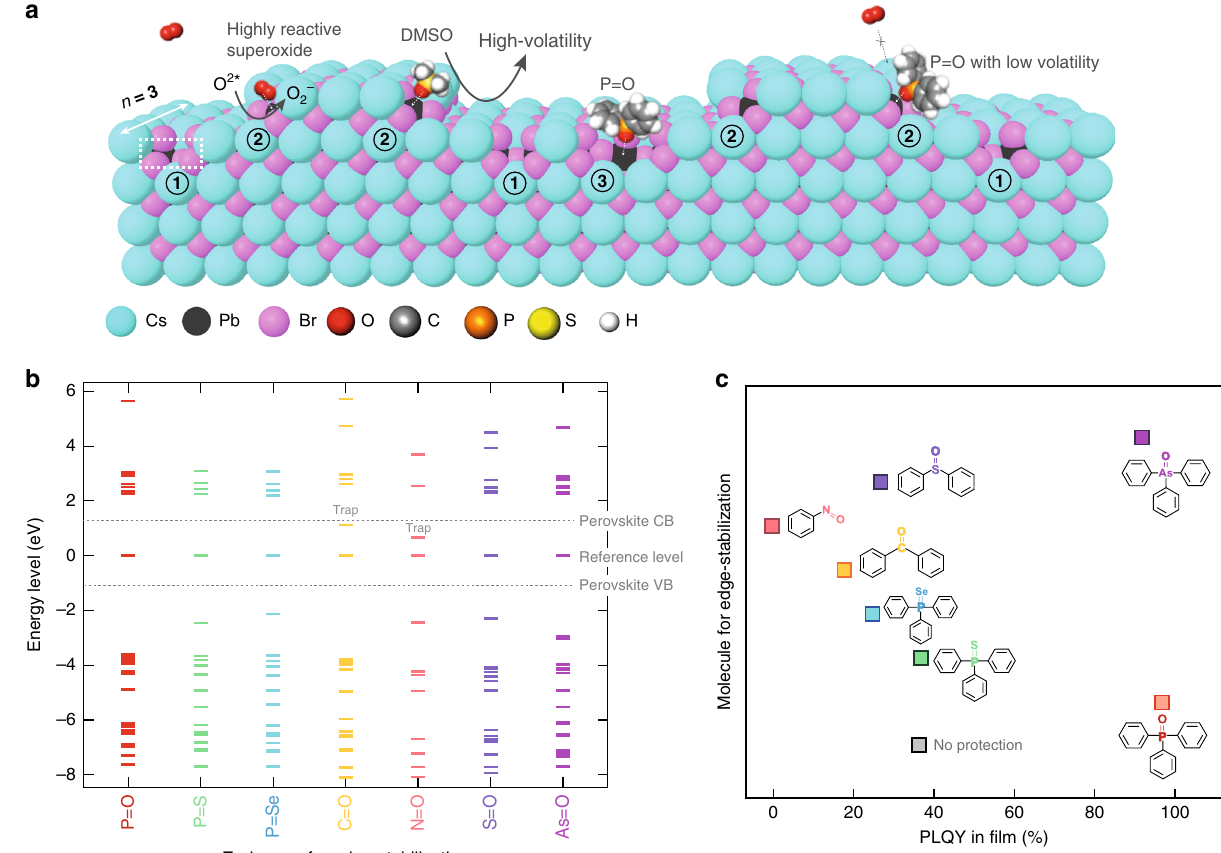
Fig. 2 Photo-induced degradation mechanisms and edge-stabilization strategy. a Schematic illustrating imperfect edges in n = 3 reduced-dimensional perovskites of PEA 2 Cs n − 1 Pb n Br 3 n + 1 and proposed reaction pathway of superoxide production under photoexcitation, including (1) missing Cs + or PEA + at the edge sites, (2) missing Cs + or PEA + at the corner sites, (3) desorbed CsBr or PEABr near the defect. b Energy level alignment obtained from DFT calculations. c PLQYs of the perovskites treated using different